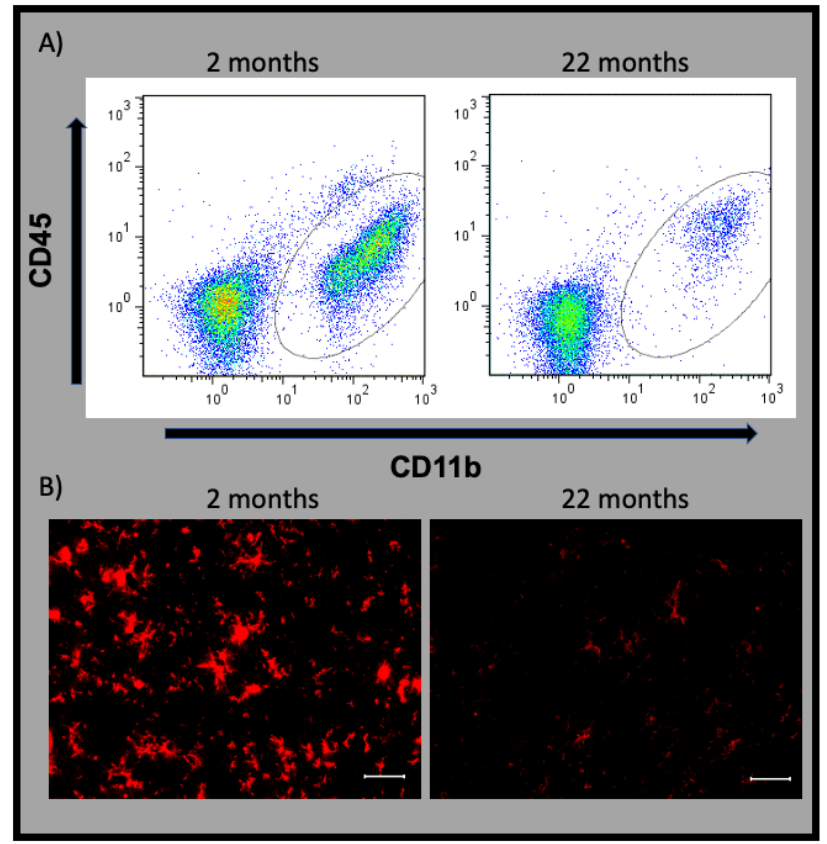
Figure 1. Age-induced drastic decline of the microglial cell population, as revealed by flow cytometry with CD45 and CD11b staining. Microglia are identified ( A ) within gray circles and ( B ) with immunofluorescent Iba1 staining (red). Prefrontal brain tissue of 2- and 22-month-old male Wistar rats was used for flow cytometry and immunofluorescence, as described in our previous study [12]. Brain sampling was performed at Zeitgeber time (ZT) 7. Scale bar = 40 µ